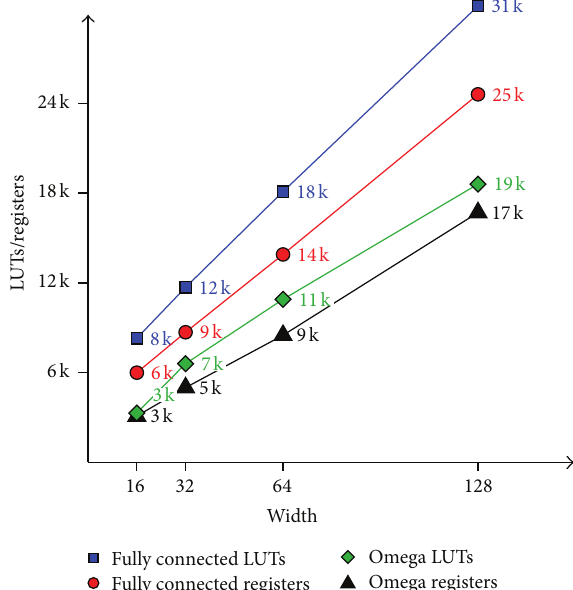
Figure 16: The effect of varying the bit width of the memory on FPGA resource